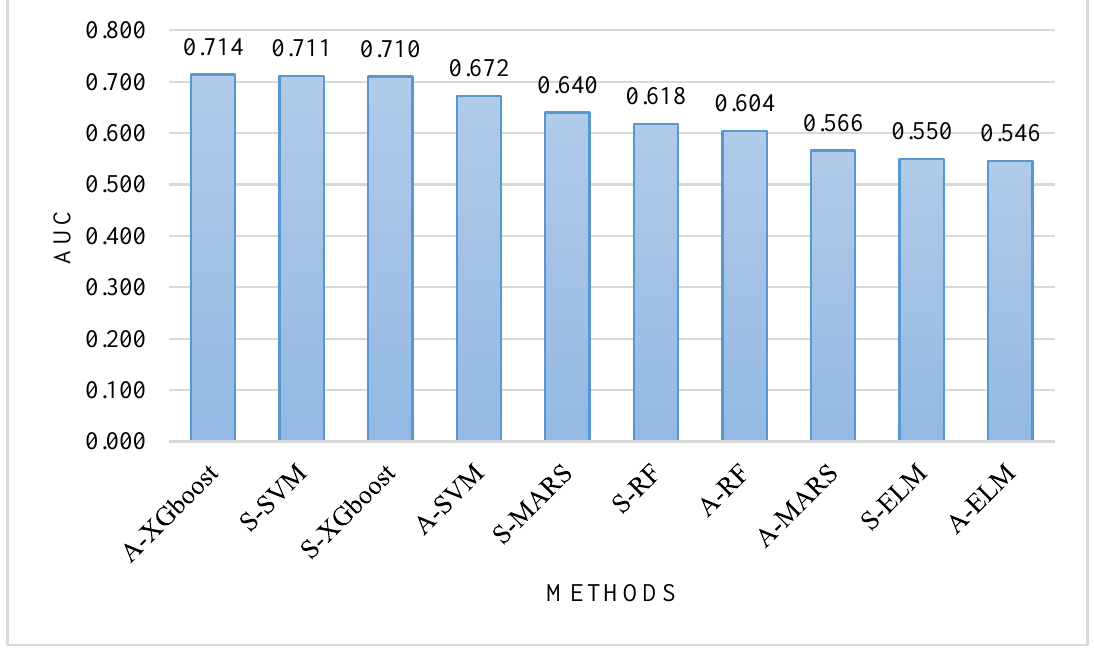
Figure 5. Comparison of the area under the curve (AUC) values of the ten models.